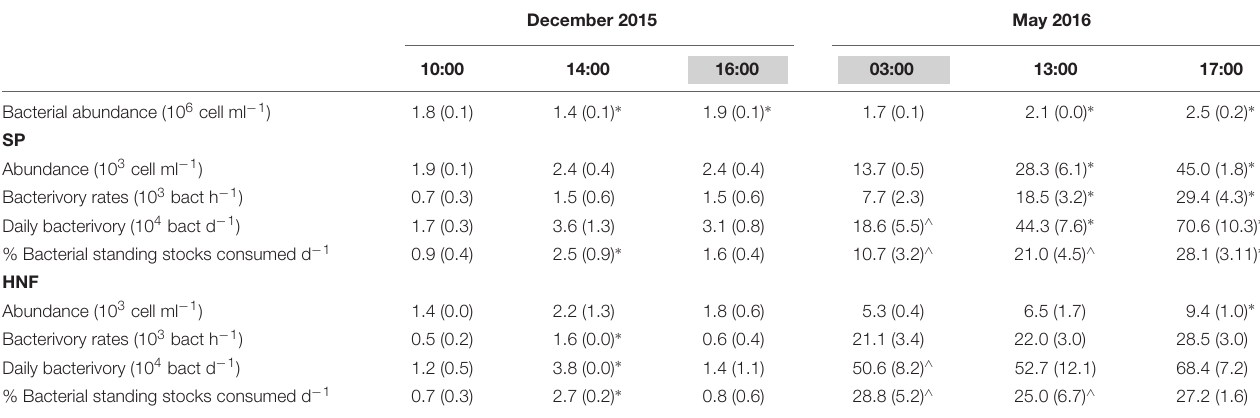
TABLE 4 | Average bacterial abundance and total HNF and SP abundance, measured hourly bacterivory rates and estimated daily bacterivory rates for December 2015 and May 2016 (standard deviation in parenthesis).